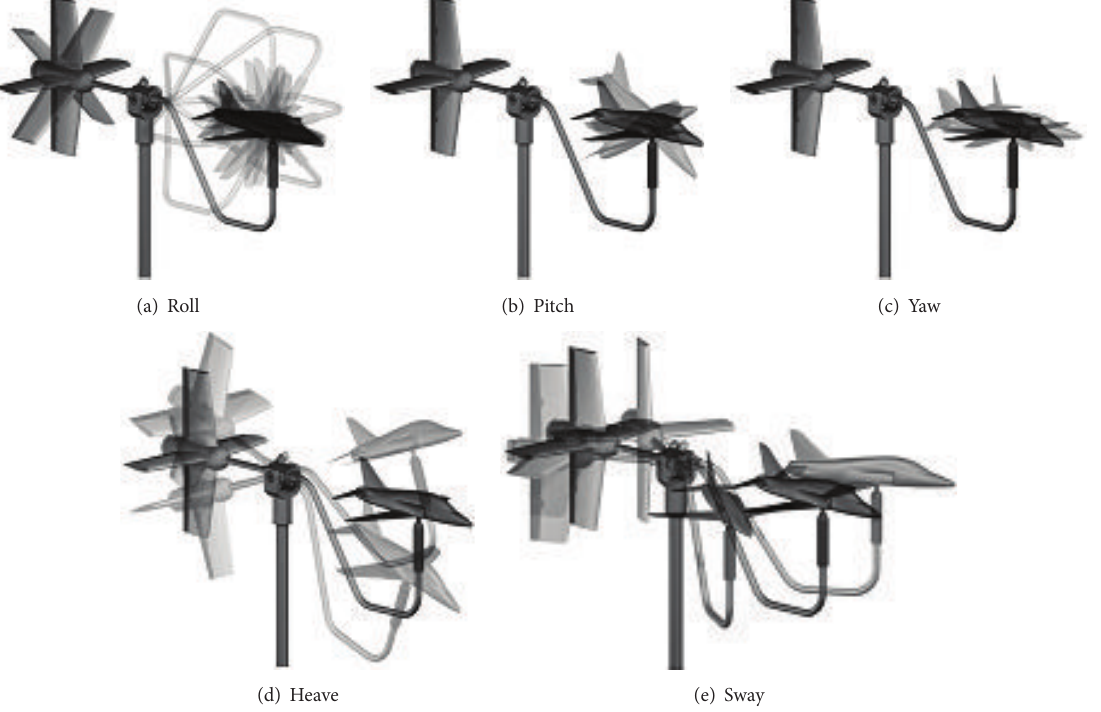
Figure 20: Illustration of the five available degrees of freedom